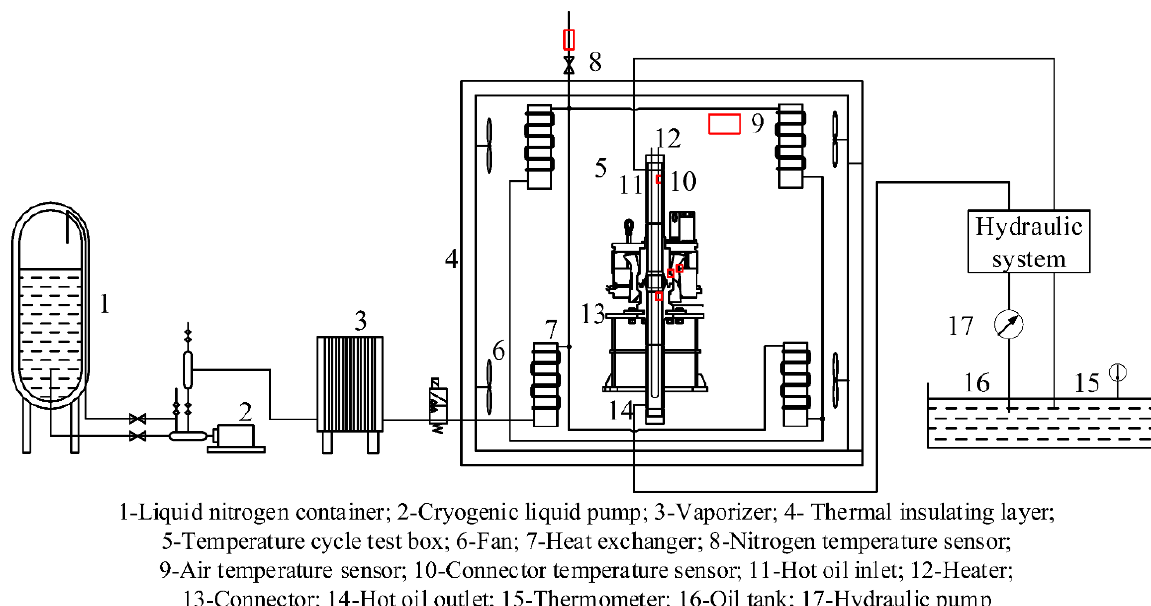
Figure 10. Schematic diagram of temperature cycle test.